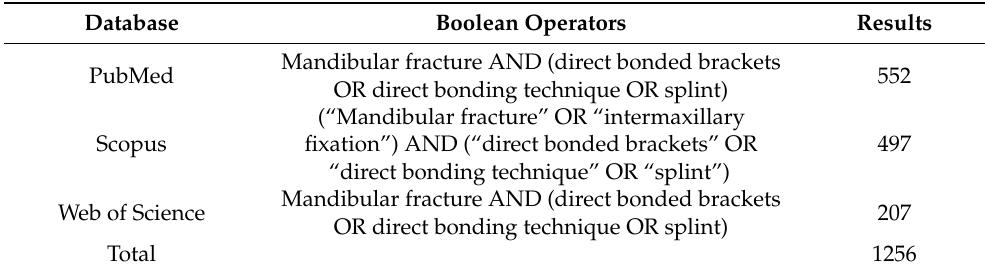
Table 1. Records identified in the different